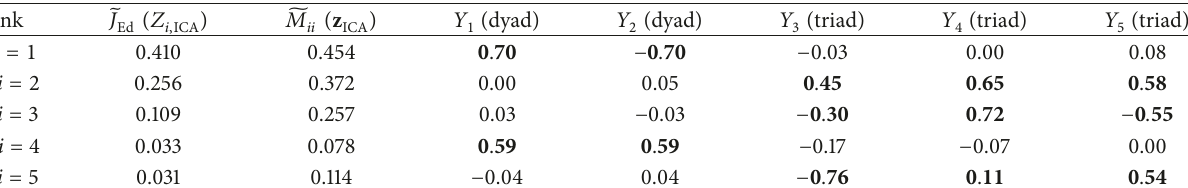
Table 4: Table 3 but for the case of intermediate noise (b).